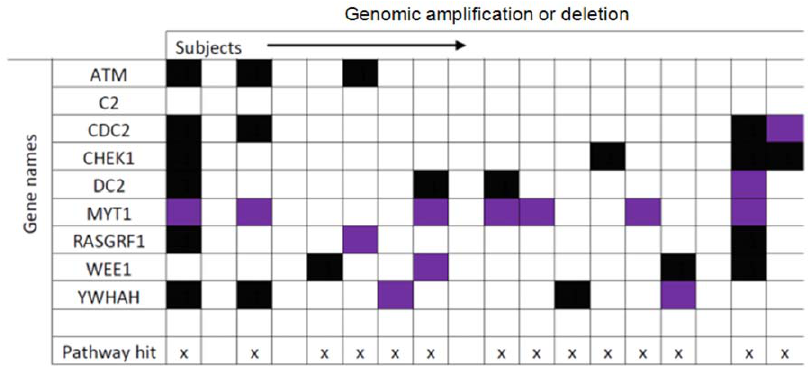
Figure 1. Copy Number alterations in 18 subjects in the ‘‘CDC25 and CHK1’’ pathway. Purple rectangles signify gene amplification and black squares signify deletion. Each column represents a randomly chosen subject with a total of 18 subjects. Each row represents a different gene of the pathway genes. Different subjects target the ‘‘CDC25 and CHK1’’ pathway through alternating genomic strategies. The pathway as a unit, however, is targeted throughout the population.